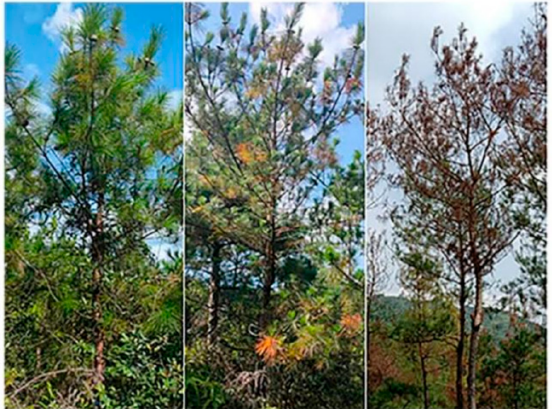
Figure A1. Three stages of pine infected with pine wood nematode disease. From left to right are the initial stage, medium stage, and terminal stage of the